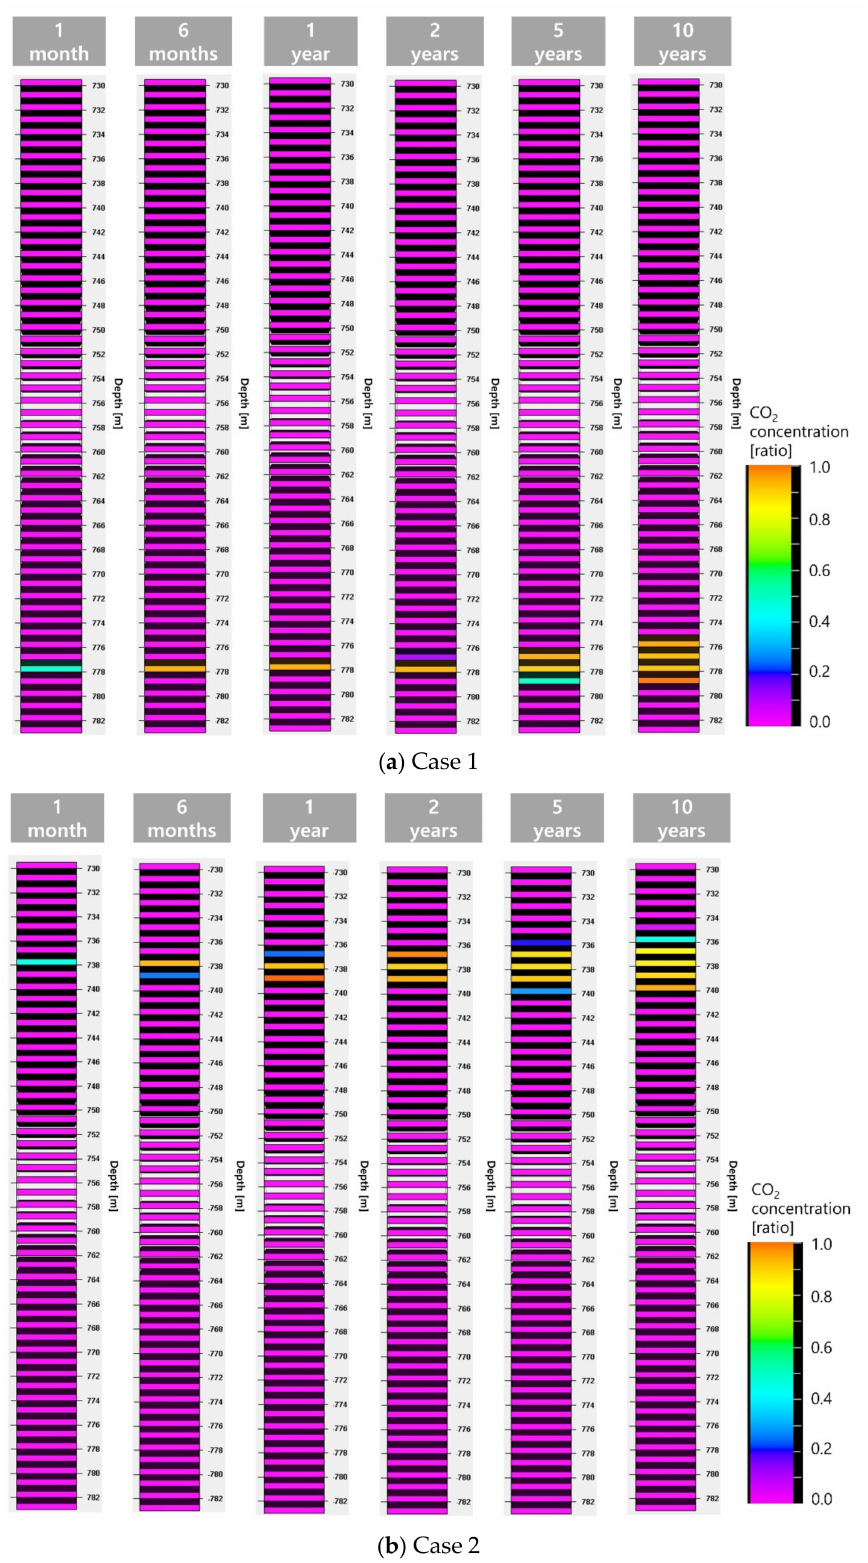
Figure 12. CO 2 concentration over the interval 730 m to 783 m at 1 month, 6 months, 1 year, 2 years, 5 years, 10 years for ( a ) Case 1 and ( b ) Case